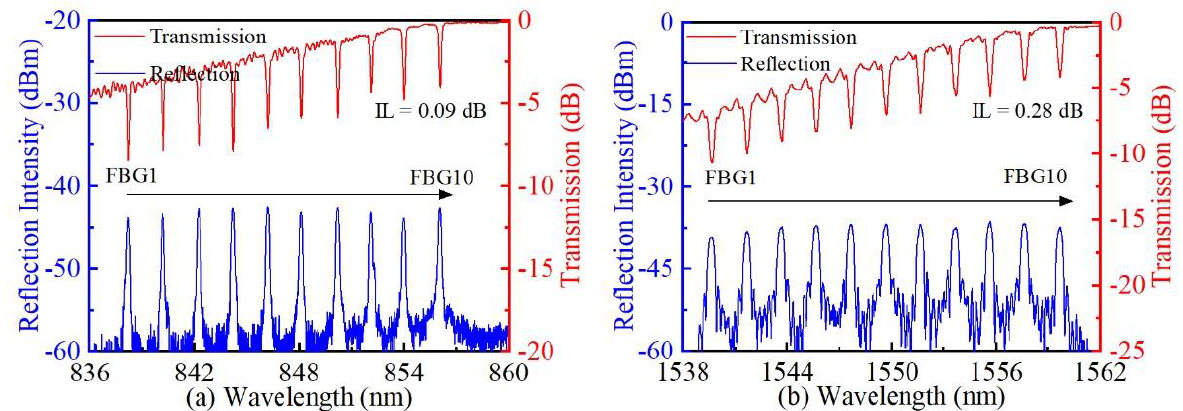
Figure 7. Transmission and reflection spectra of FBG WDM arrays consisting of 10 FBGs with Bragg wavelengths ranging ( a ) from 838 to 856 nm and ( b ) from 1538 to 1562 nm.